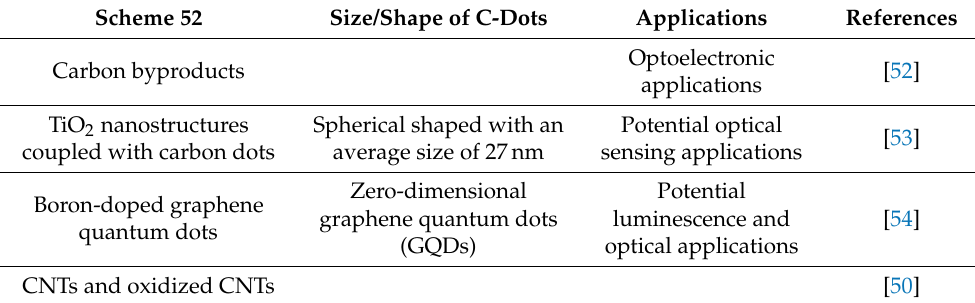
Table 2. Arc-discharge-based approaches for the synthesis of